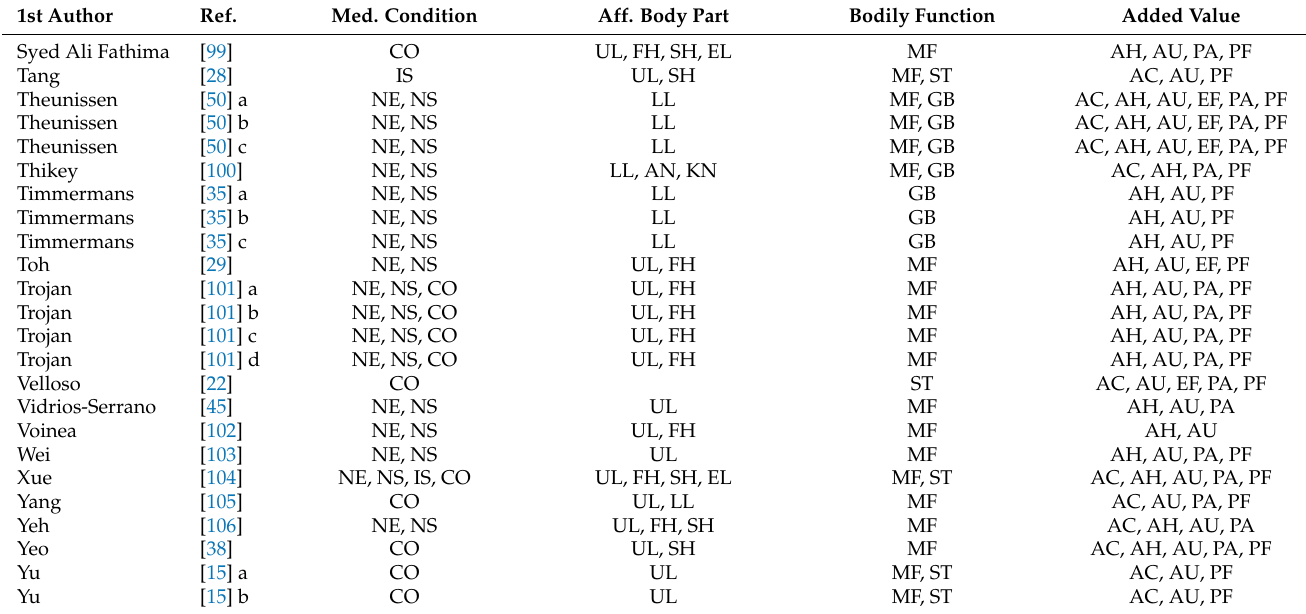
Table A5. Overview of the selected references—author names Sy–Z, part 1/2, Abbr. in Table A7. Distinct applications within a reference are marked with lowercase letters.